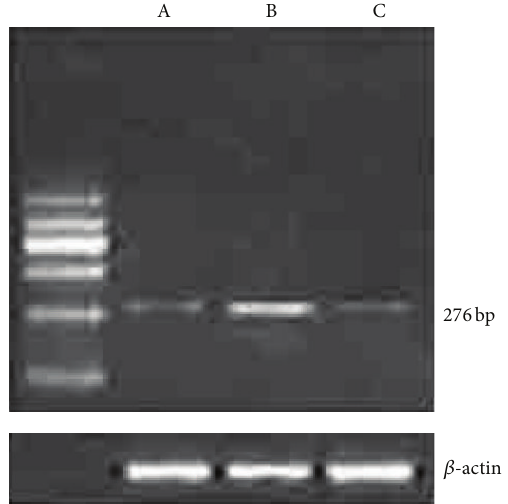
Figure 5: Semiquantitative RT-PCR analysis of laminin mRNA expression. Significantly higher laminin mRNA expression was observed in the pre-SNP group (B) compared to SBT (A) and post- SNP group